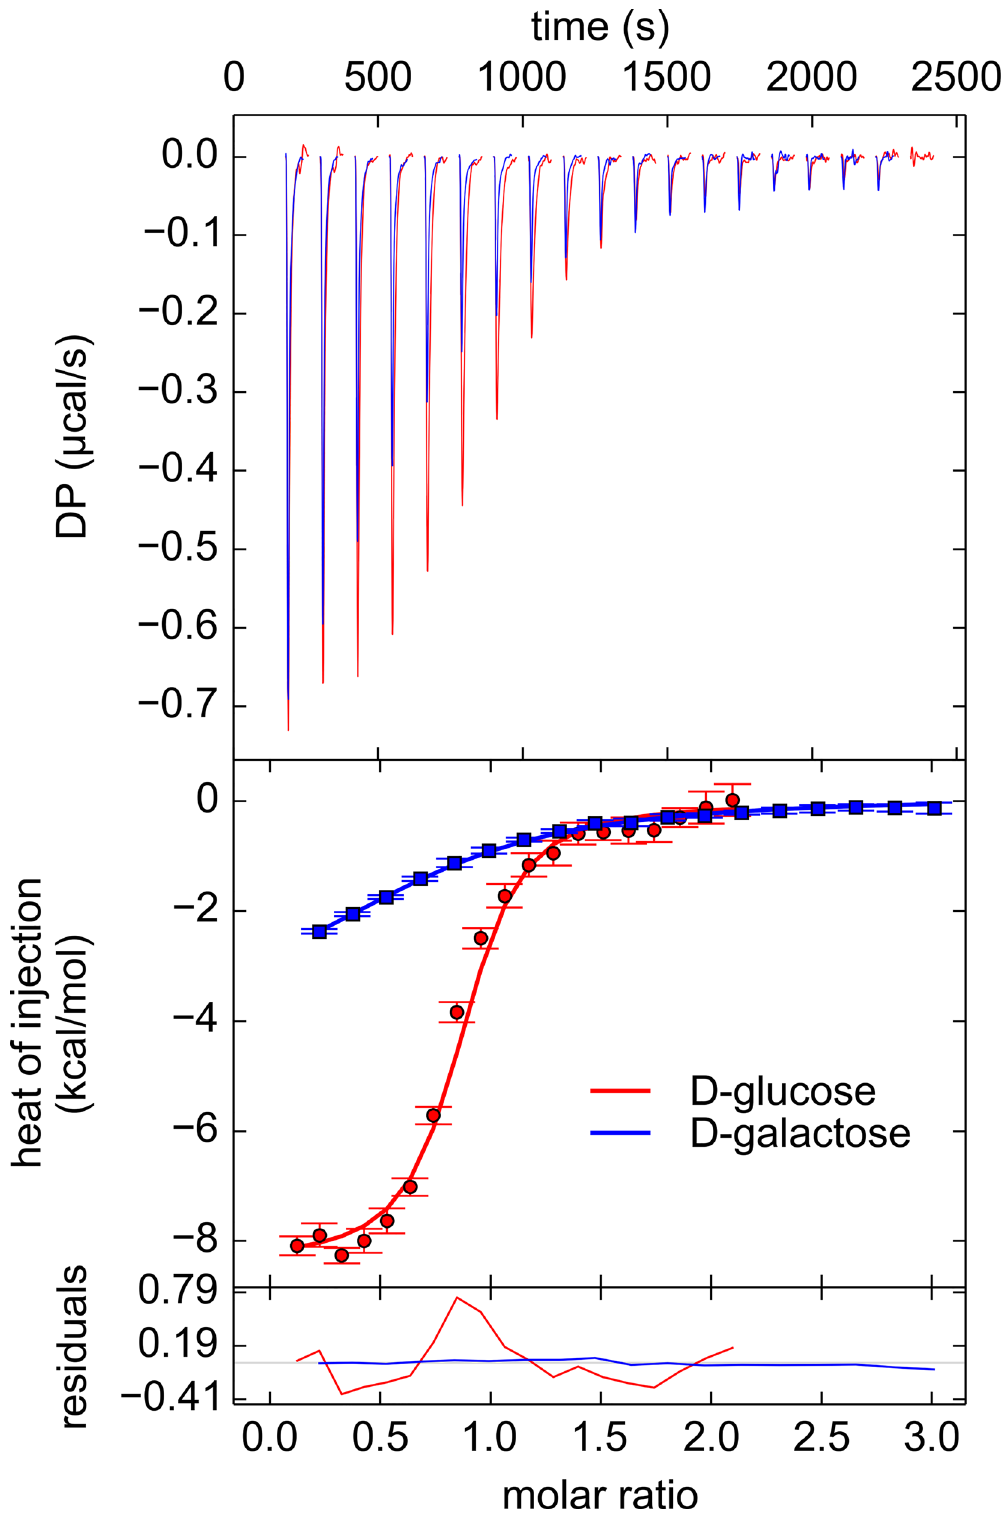
Fig 6. D-glucose and D-galactose binding TpMglB-2. Baseline-subtracted thermograms reconstructed from the raw data using singular-value decomposition are shown in the top panel. In the middle panel are the integrated heats of injection (markers) with error bars depicted estimated measurement errors [54,55]. The lines are fits to